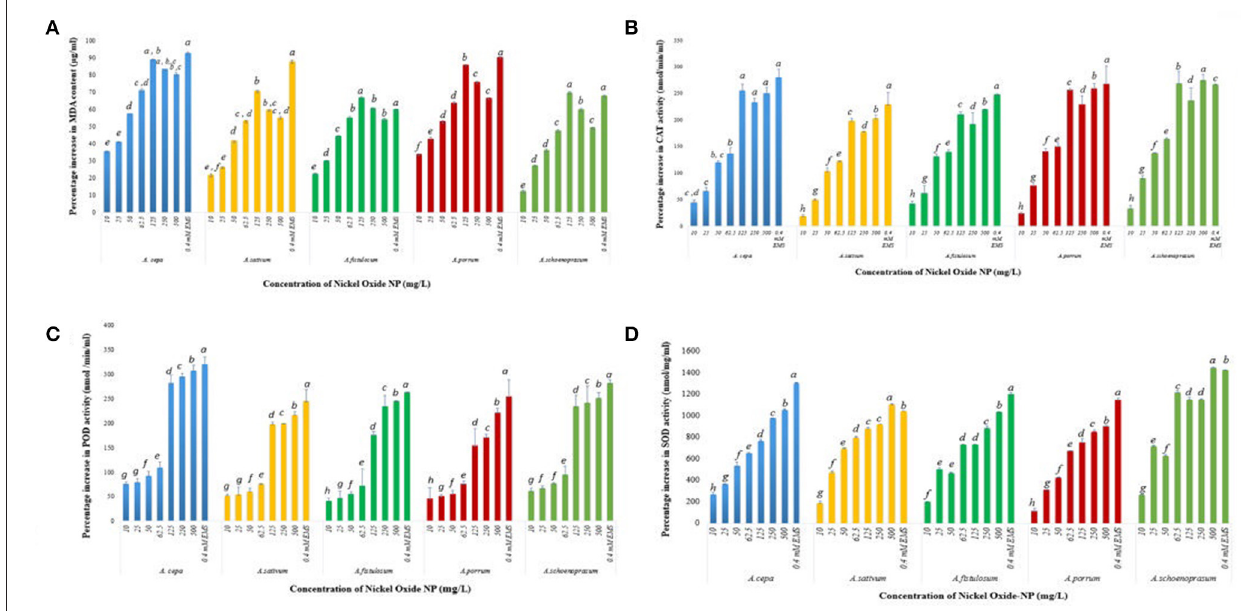
FIGURE 9 | (A) Effect of increasing NiO-NP concentration on malonaldehyde content (lipid peroxidation) in the treated samples; (B) Effect of increasing NiO-NP concentration on catalase activity; (C) Effect of increasing NiO-NP concentration on POD activity; (D) Effect of increasing NiO-NP concentration on SOD activity, expressed as percentage change, expressed as percentage change ( p <